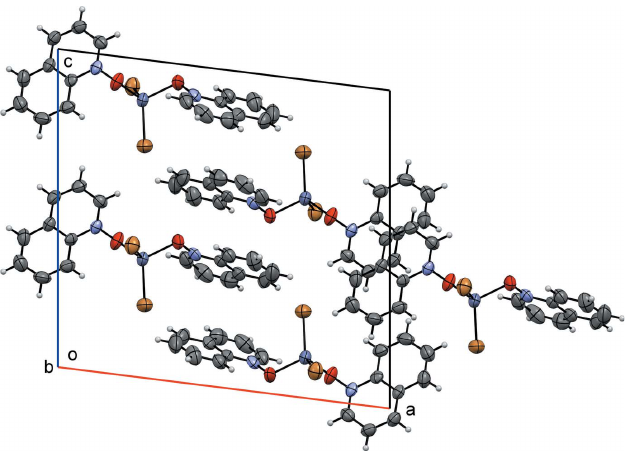
Figure 6 Crystal packing diagram of compound ( II ), viewed down the b axis.